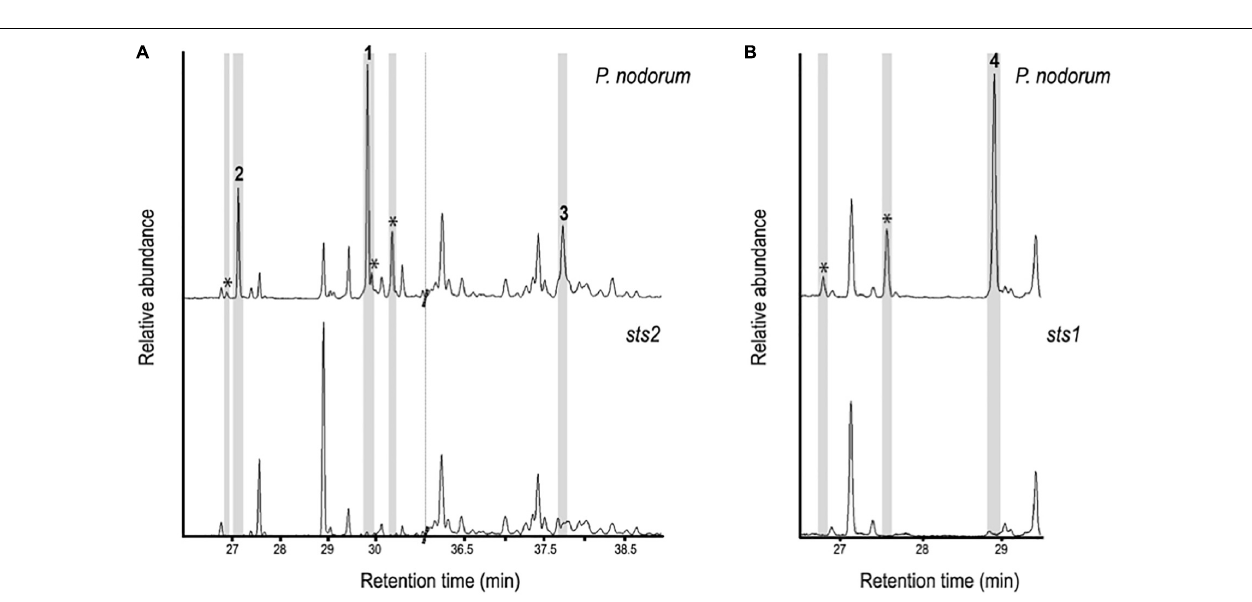
FIGURE 3 | (A) Sesquiterpene profile of P. nodorum growing on Fries media (upper panel) and uninoculated Fries media (lower panel). (B) The sesquiterpene profile of wheat leaves infected with P. nodorum (upper panel) and mock inoculated wheat leaves (low panel). Compounds 1-4 are shown and other sesquiterpenes peaks are stared (*). Mellein is indicated as a cross (+).